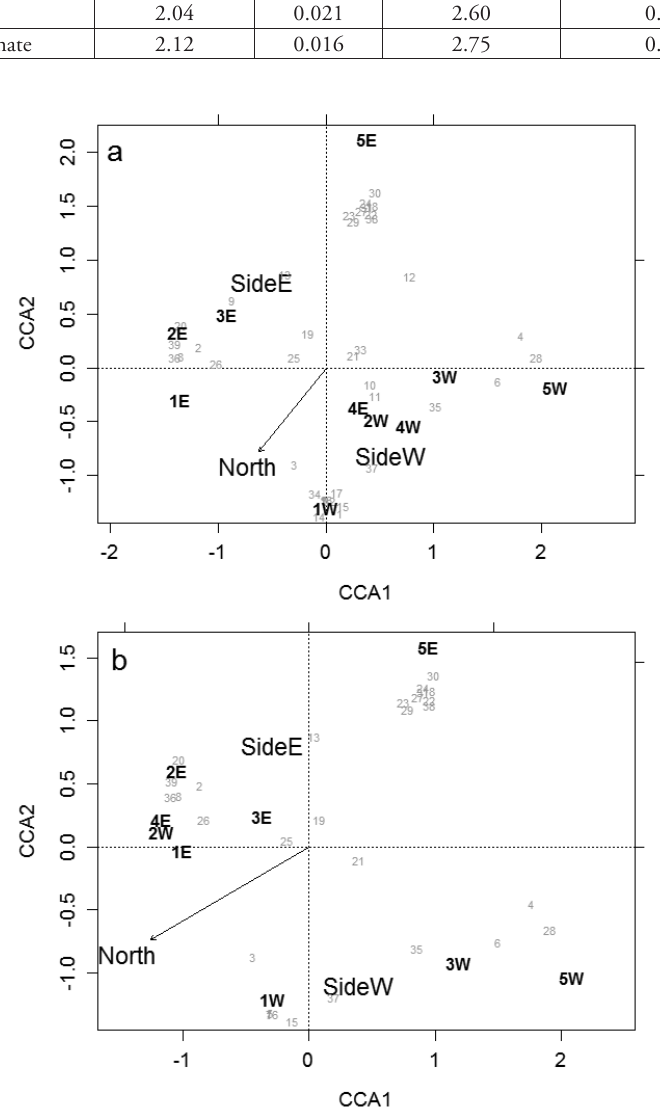
Figure 2. Ordination plots for communities of bees and wasps along the E4 in Sollentuna, where a shows the result for the analysis of the whole community and b the result for the analysis where the large spe- cies (>16 mm) were excluded. Grey small numbers refer to different species (Suppl. material 1) and black larger text shows the sites and the two explanatory variables (eastern or western side of the road, and the north-south gradient). To improve visualization the species are plotted with a small